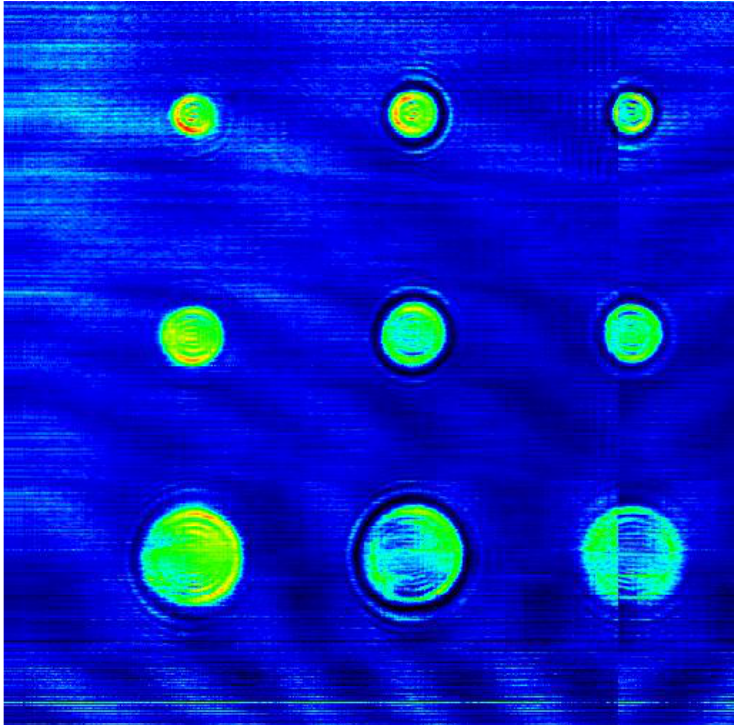
Figure 12. THz image of a glass – fiber reinforced composite with defects in the form of incomplete holes.